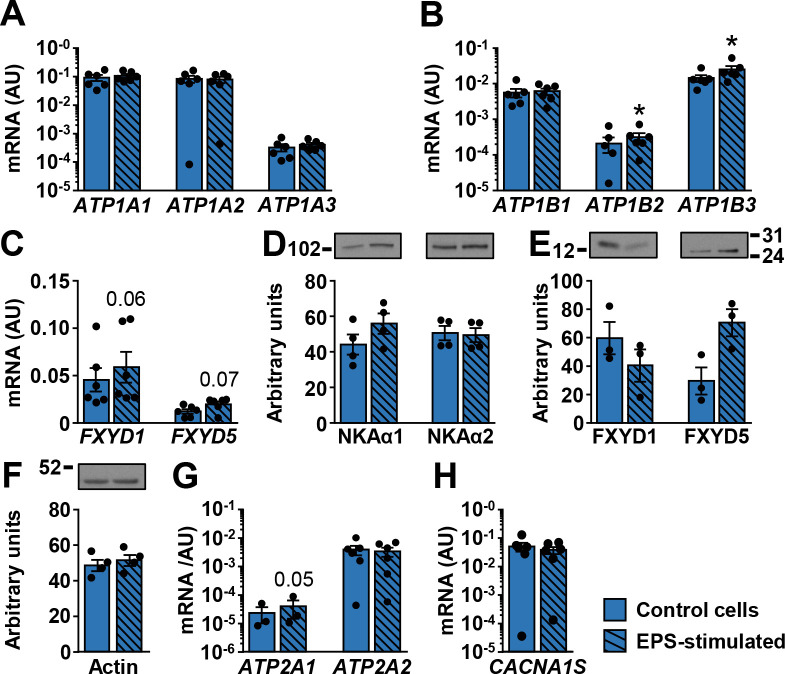
Effect of EPS on the ion transport machinery in human myotubes.qPCR was used to estimate gene expression of (A) NKAα1–3 (ATP1A1-3), (B) NKAβ1–3 (ATP1B1-3), (C) FXYD1 and FXYD5, (G) SERCA1 (ATP2A1) and SERCA2 (ATP2A2), and (H) CACNA1S. A geometric mean of ACTB and PPIA was used for normalization of gene expression. Immunoblotting was used to estimate protein abundance of (D) NKAα1 and NKAα2, (E) FXYD1 and FXYD5, and (F) actin. Results are means ± SEM (n = 3–6), *P<0.05 vs non-stimulated (Control) cells.